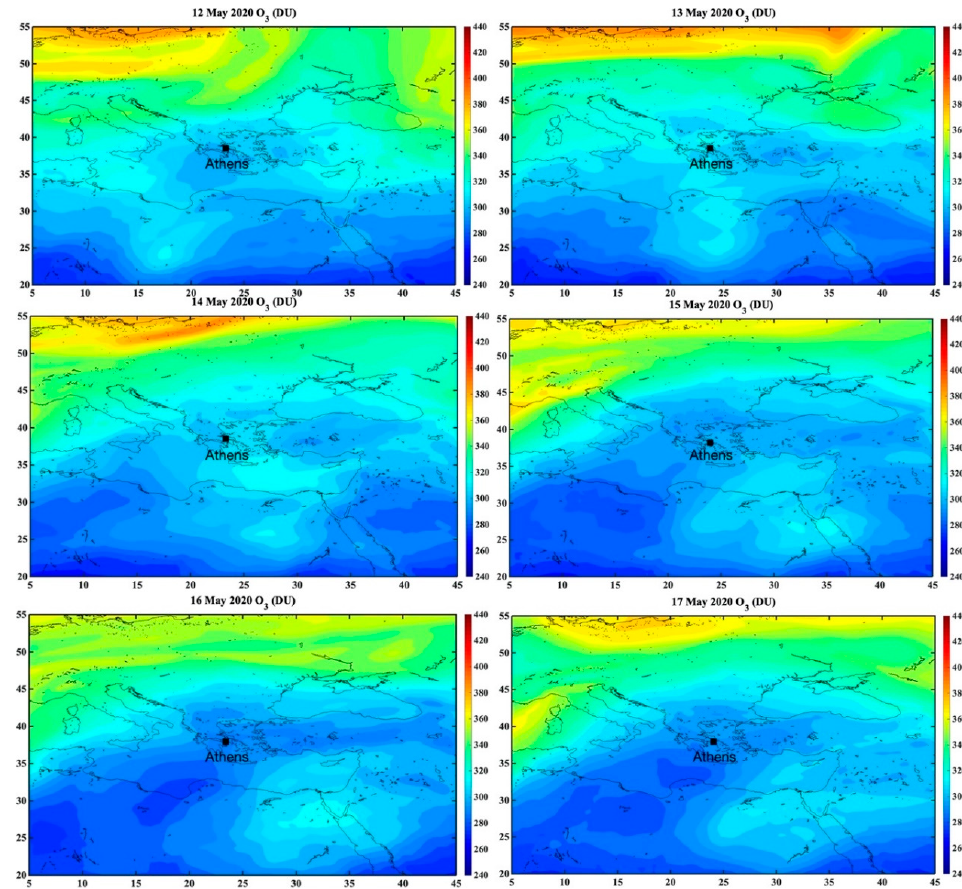
Figure 2. Spatial variability of TOC in the Eastern Mediterranean for 12–17 May 2020, as retrieved by the Copernicus Atmospheric Monitoring Service (CAMS).